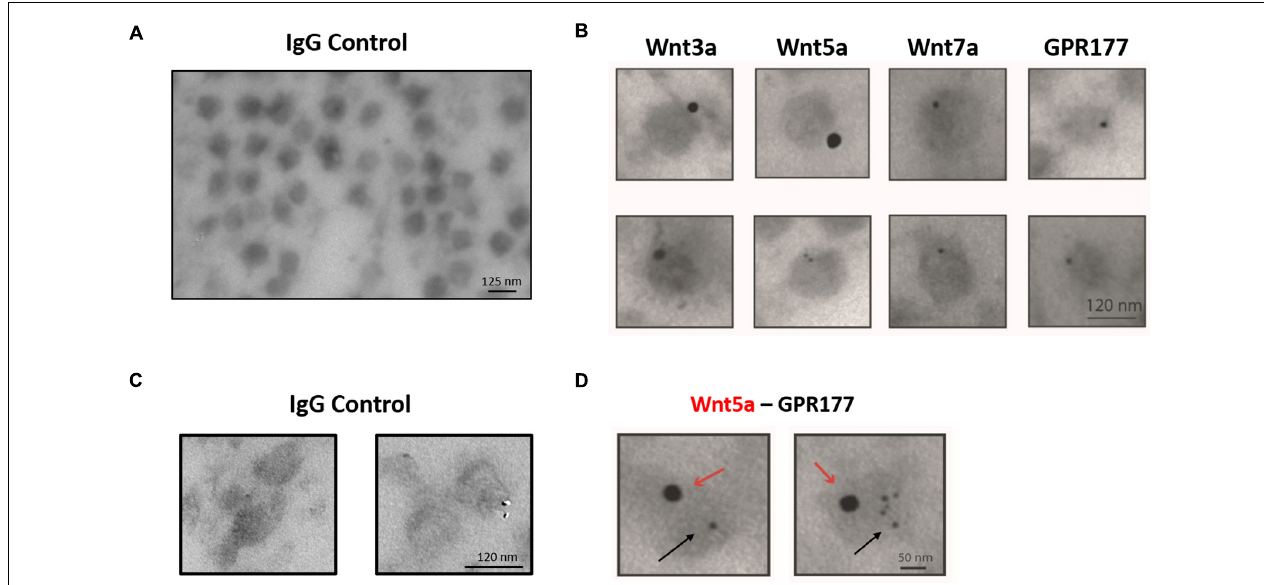
FIGURE 3 | Immunogold-TEM characterization of HT-22 exosomes. (A) IgG control for single immunogold labeling. (B) Single immunogold labeling shows that exosome-like vesicles secreted by HT-22 cells express Wnt3a, Wnt5a, Wnt7a, and GPR177. (C) IgG control for double immunogold. (D) Doubled immunogold analysis detected co-expression of Wnt5a and GPR177. Red and black arrows show the presence of Wnt5 and GPR177,